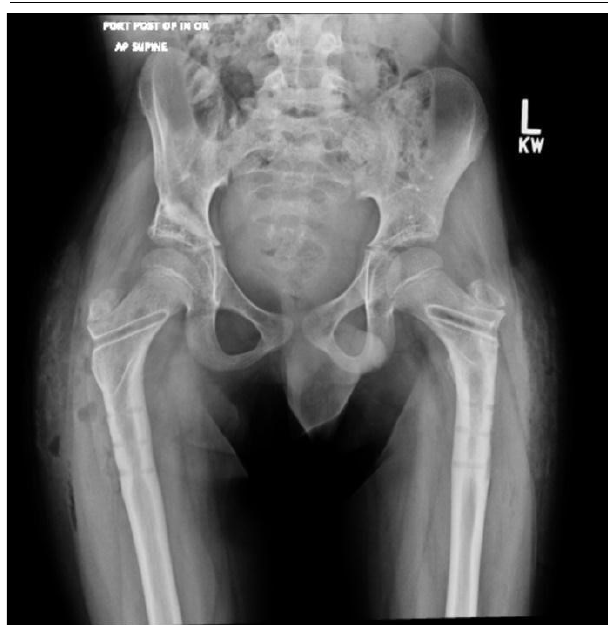
Figure 5 . Postoperative X-Ray After Implant Removal.